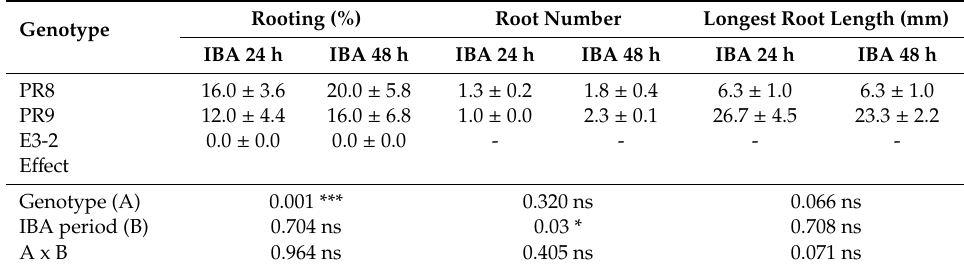
Table 5. E ff ect of indol-3-butiric acid (IBA) treatment period and genotype on the rooting ability of shoots from three tolerant Quercus ilex genotypes.